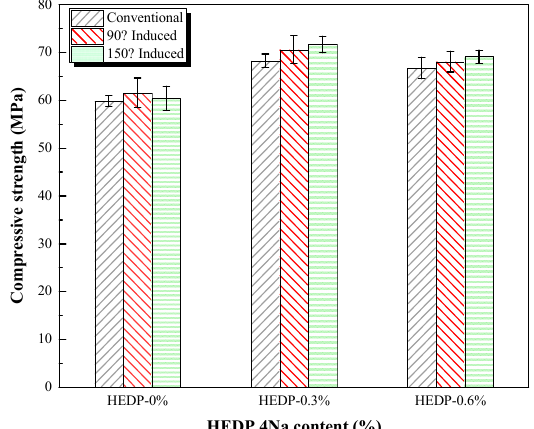
Figure 3. Compressive strength of 28d FR-AASC.